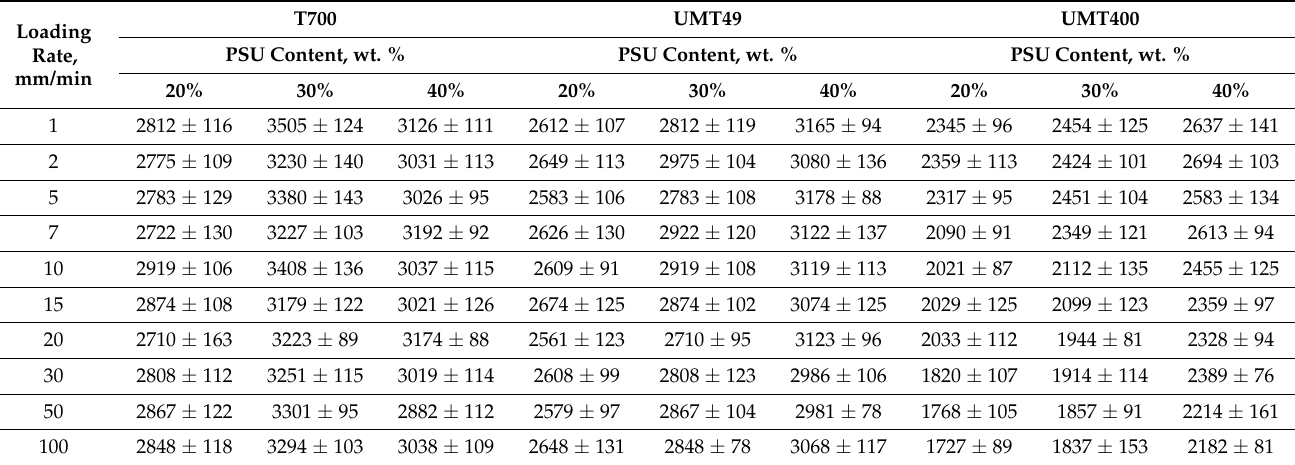
Table 2. Dependence of the strength of carbon fiber–polysulfone composites on the loading rate and polysulfone